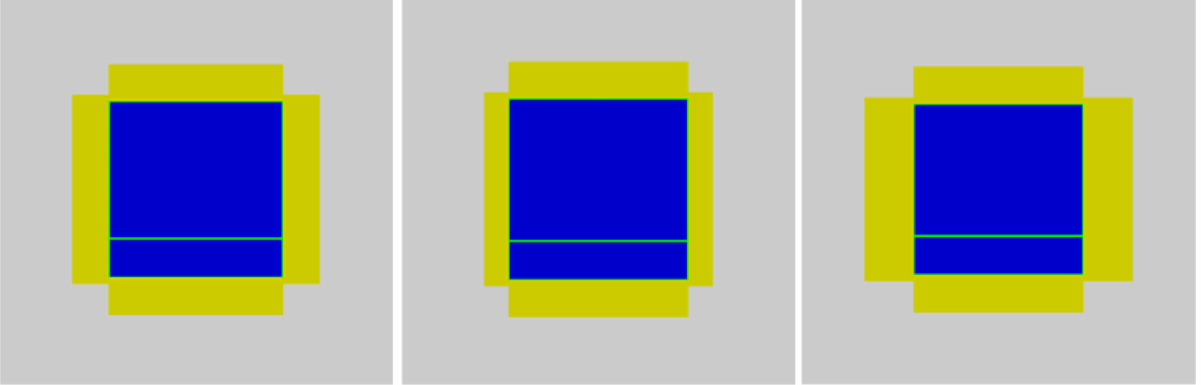
Figure 10. Cases for the investigation of the effect of different reflector thicknesses of the movable radial reflector on the control reactivity curve (left 30 cm reflector case with 140 cm diameter and 140 cm height, center 20 cm reflector case with 144 cm diameter and 144 cm height, right 40 cm reflector case with 136 cm diameter and 136 cm